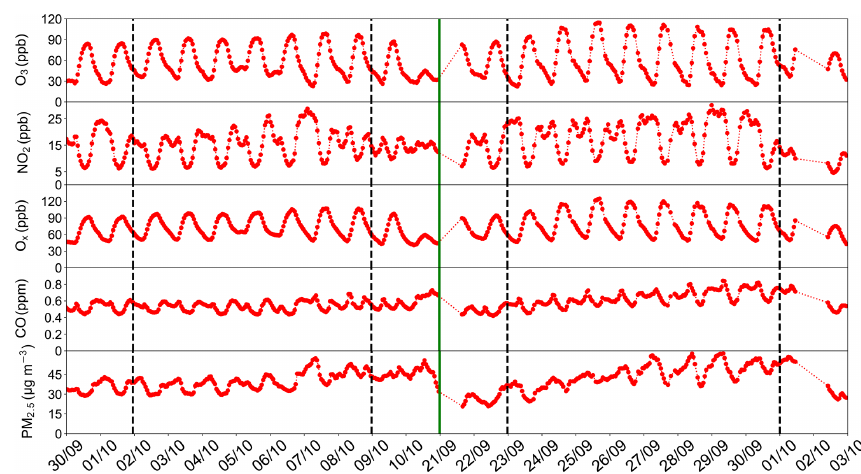
Figure 3. Hourly surface concentrations of air pollutants during the study period. The green line is added to separate the two episodes; the black dashed lines indicate 2d before and 2d after the episodes.